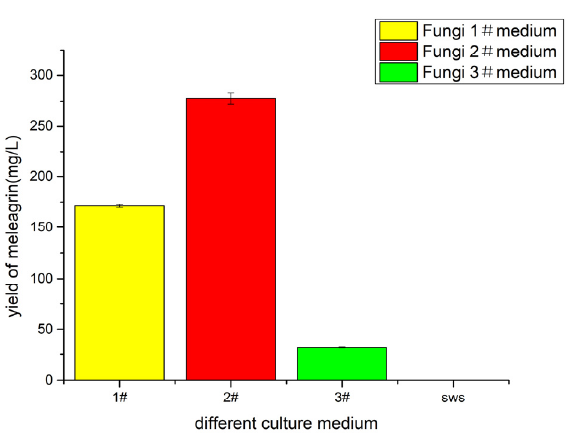
Figure 7. The yield of meleagrin in different fermentation mediums. ＃ represents the number of the culture medium.